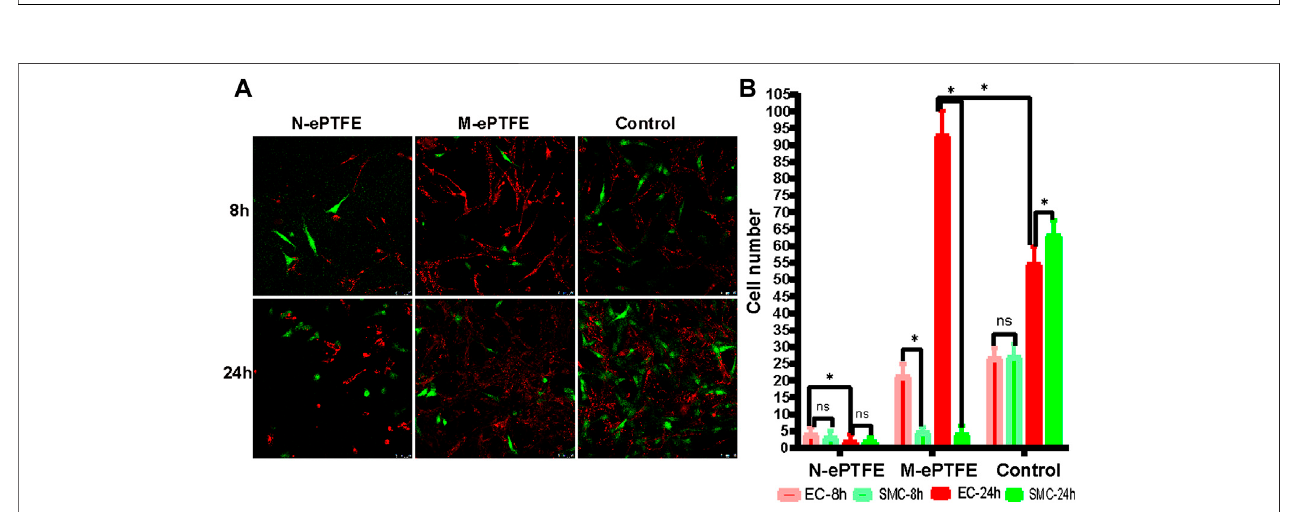
FIGURE 4 | Type and number of EC, endothelial cells; and SMC, smooth muscle cells; co-cultured on unmodi fi ed N-ePTFE/M-ePTFE, expanded polytetra fl uoroethylene , modi fi ed (M-ePTFE) or control plates (A) Distribution of EC (labeled with red dye) and SMC (labeled with green dye) in each group (scale bar = 50 μ m) (B) Numbers of EC and SMC after co-culturing for 8 and 24 h * p < 0.05.